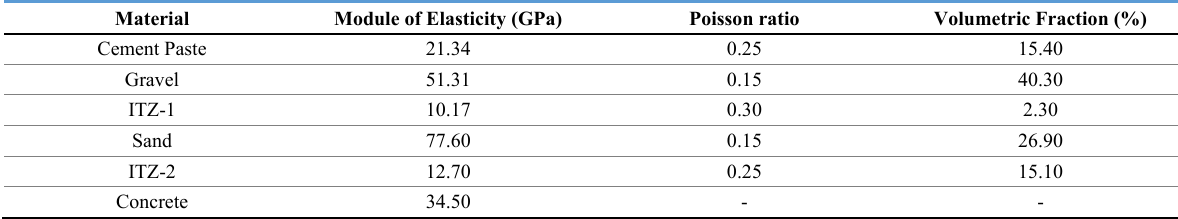
Table 2: Property of the composite phases